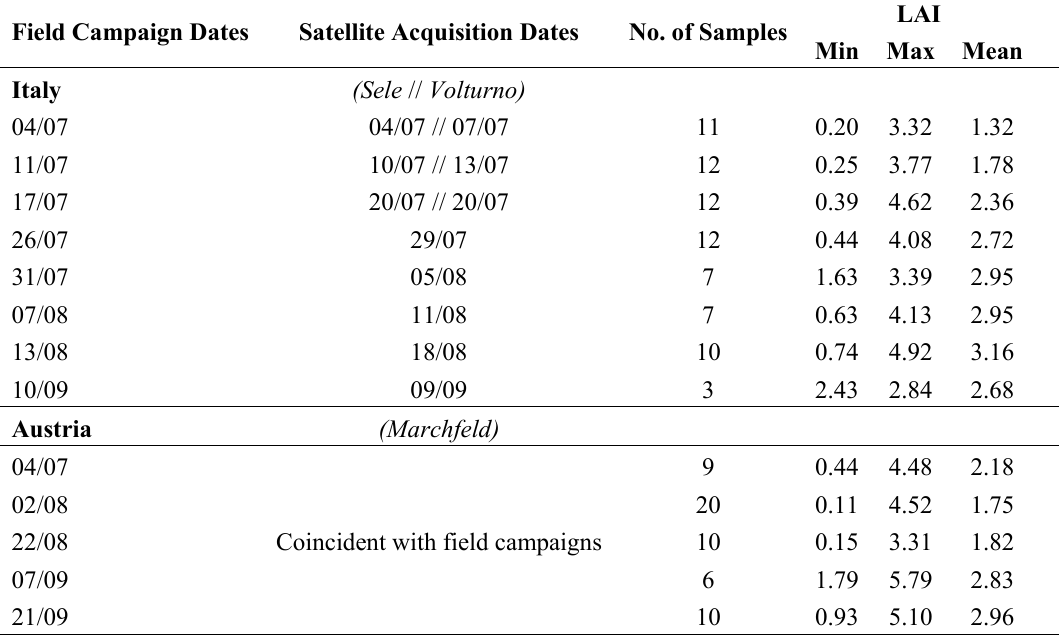
Table 2. Timing of the field campaigns and satellite acquisitions with corresponding statistics of the LAI measurements. Note that acquisitions were not always performed during the same dates in the two areas ( Sele and Volturno ) of the Italian test